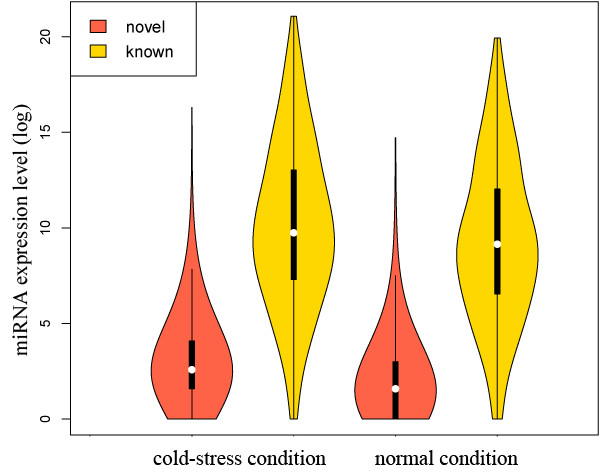
Violin plot showing the expression levels of novel-identified and known miRNAs. The violin plot combines box plot and kernel density trace to describe the distribution pattern of a vector of data. The four violin plots were drawn according to the expression levels of 525 newly identified and 175 known miRNAs under the normal and cold-acclimated condition, respectively. Note that if the expression level of a miRNA was 0 under certain condition, we assigned it to 1 in order to make the log-transfer of the raw data.